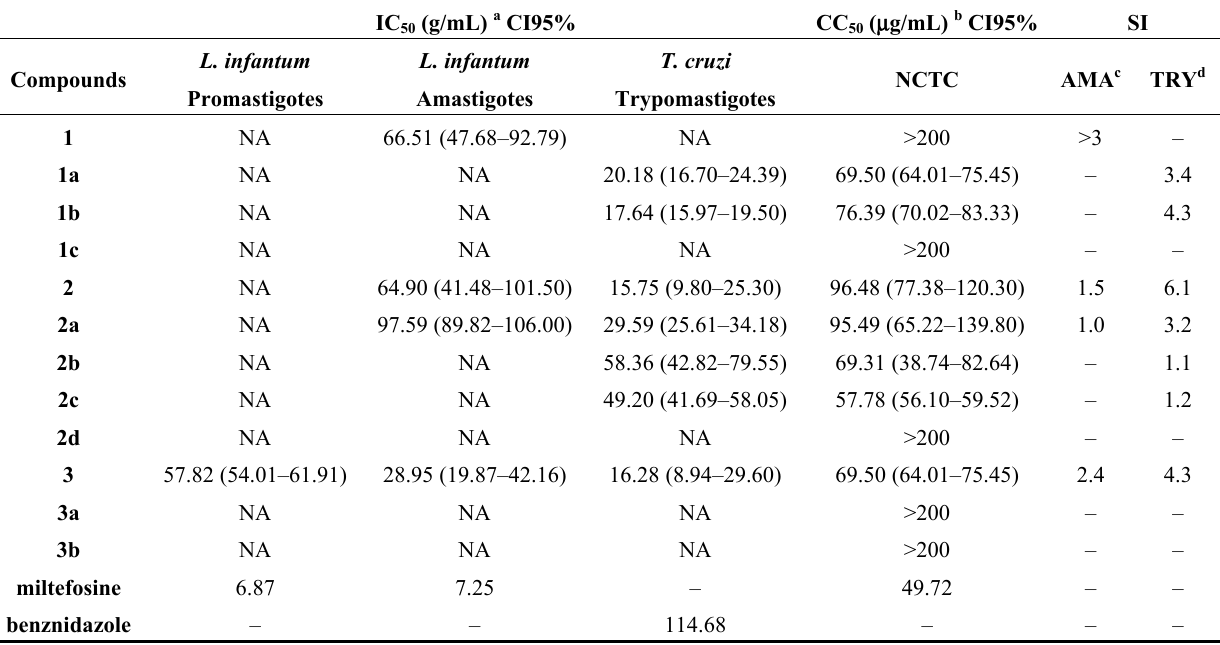
Table 1. Antiparasitic (antileishmanial and antitrypanosomal) and cytotoxic effects of natural compounds 1 – 3 , semi-synthetic 1a – c , 2a – d , 3a , and 3b and